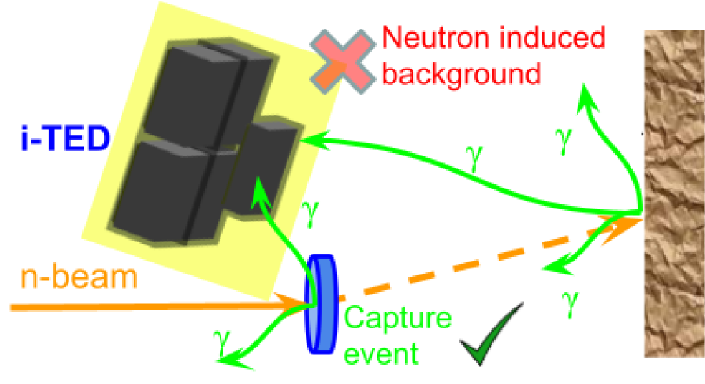
Figure 1. Scheme of a neutron-capture TOF experiment illustrating the concept of the i-TED Compton imager applied to the suppression the dominant neutron induced